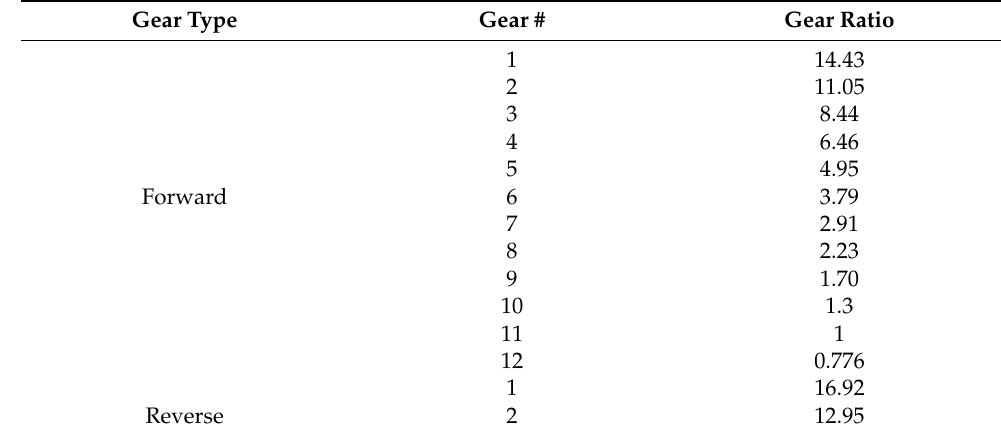
Table 1. Transmission gear ratios